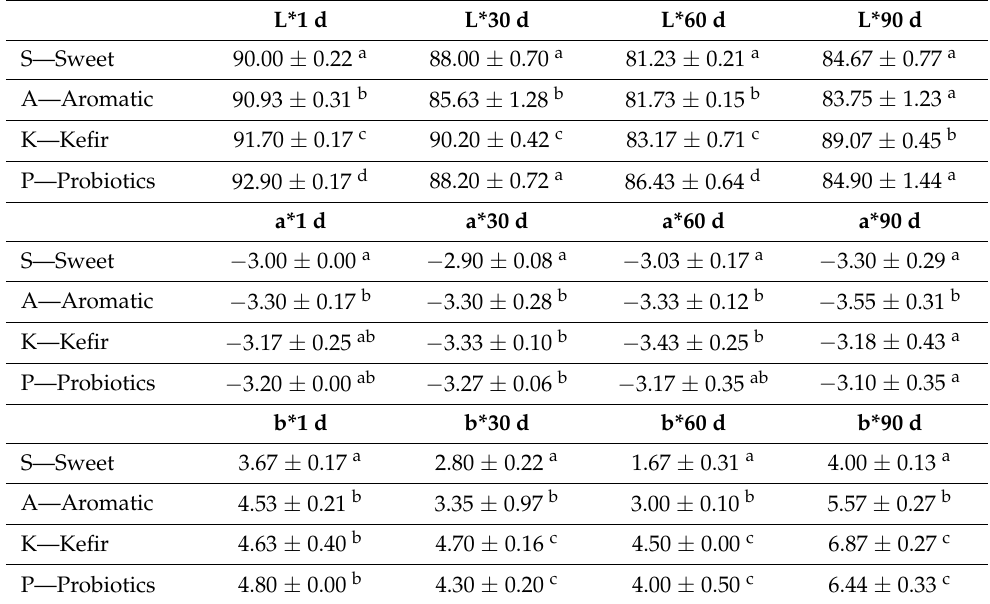
Table 2. Color parameters (L*, a*, b*) of sheep’s butters produced with sweet cream and with cream fermented with different starter cultures, over storage (1 d, 30 d, 60 d and 90 d). Average values ( ± ) standard deviation. Different superscript lowercase letters in each column (a,b,c,d) indicate significant differences ( p < 0.05) between products regarding color parameters at a specific